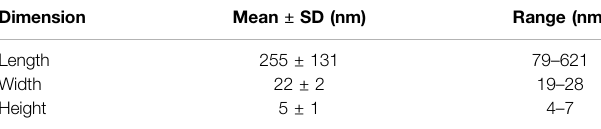
TABLE 3 | Parameters of Tau35 fi bers measured from atomic force